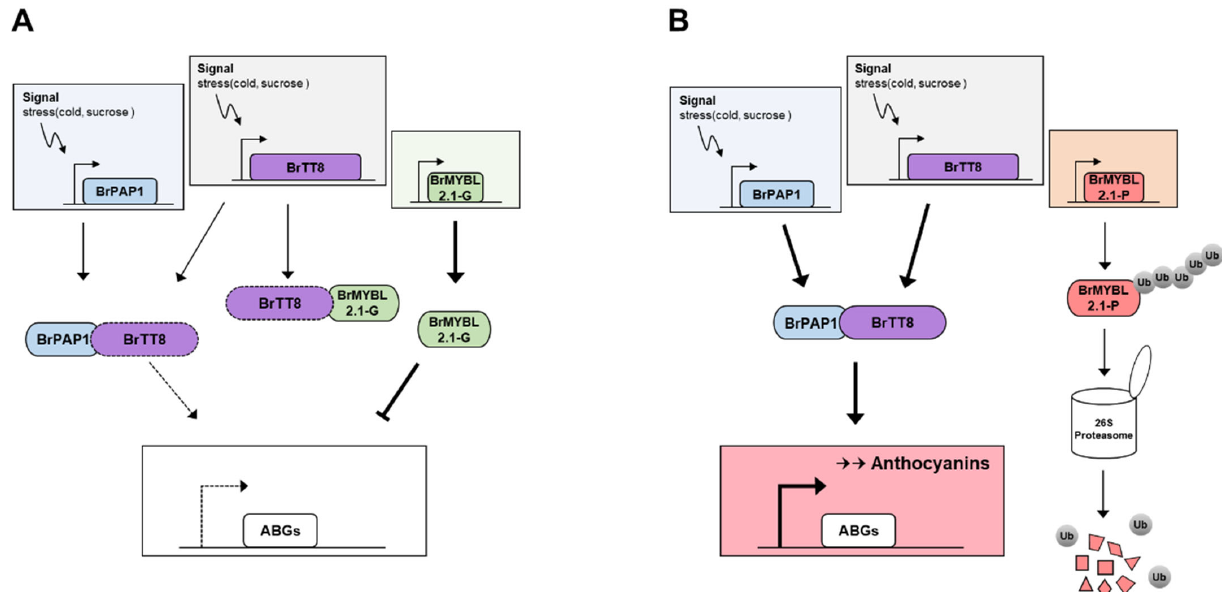
Figure 10. Proposed working model of the role of BrMYBL2.1 in anthocyanin biosynthesis in green ( A ) and purple ( B ) Chinese cabbage. Arrows and blunt arrows represent positive and negative regulation, respectively.